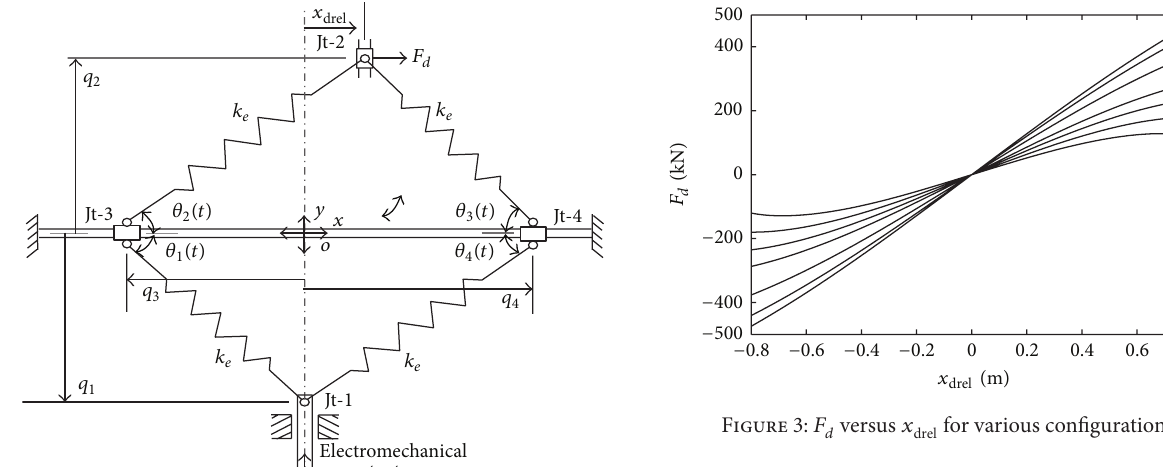
Figure 3: 𝐹 𝑑 versus 𝑥